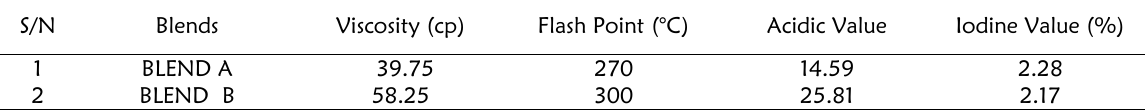
Table 2: Physical properties of the blends